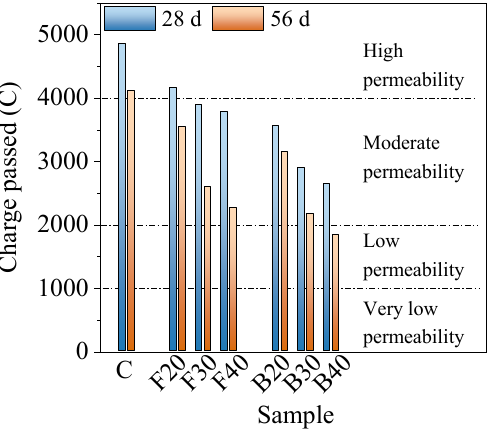
Figure 5. The charge passed and corresponding permeability grades of the concrete containing FA and GGBS under an equal 28-day strength grade.